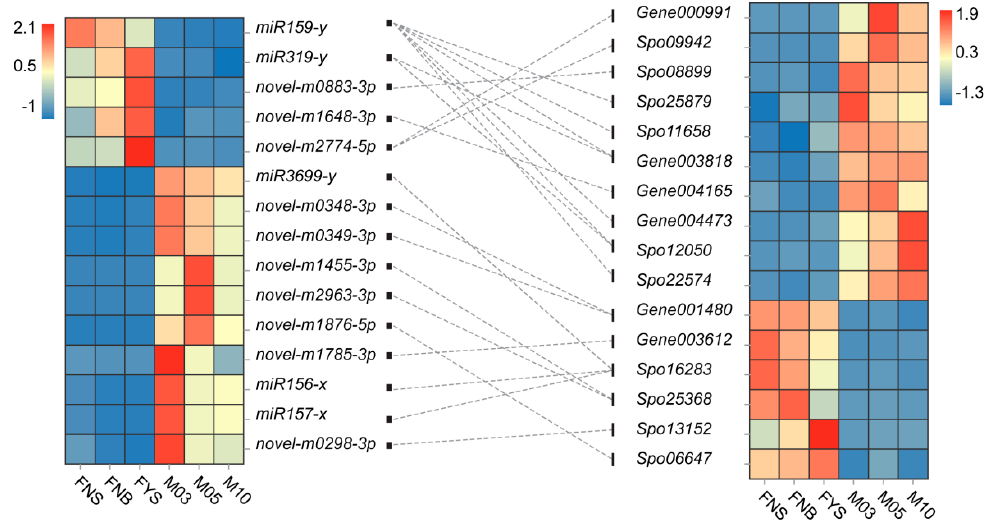
Figure 3. 22 pairs of sex-biased miRNA-target. The heatmaps represent the expression profile of 15 sex-biased miRNAs ( left ) and 16 sex-biased target genes ( right ); the dotted line links miRNA and its target.